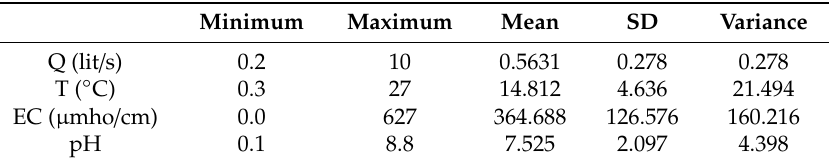
Table 1. Statistical measure of springs in the study